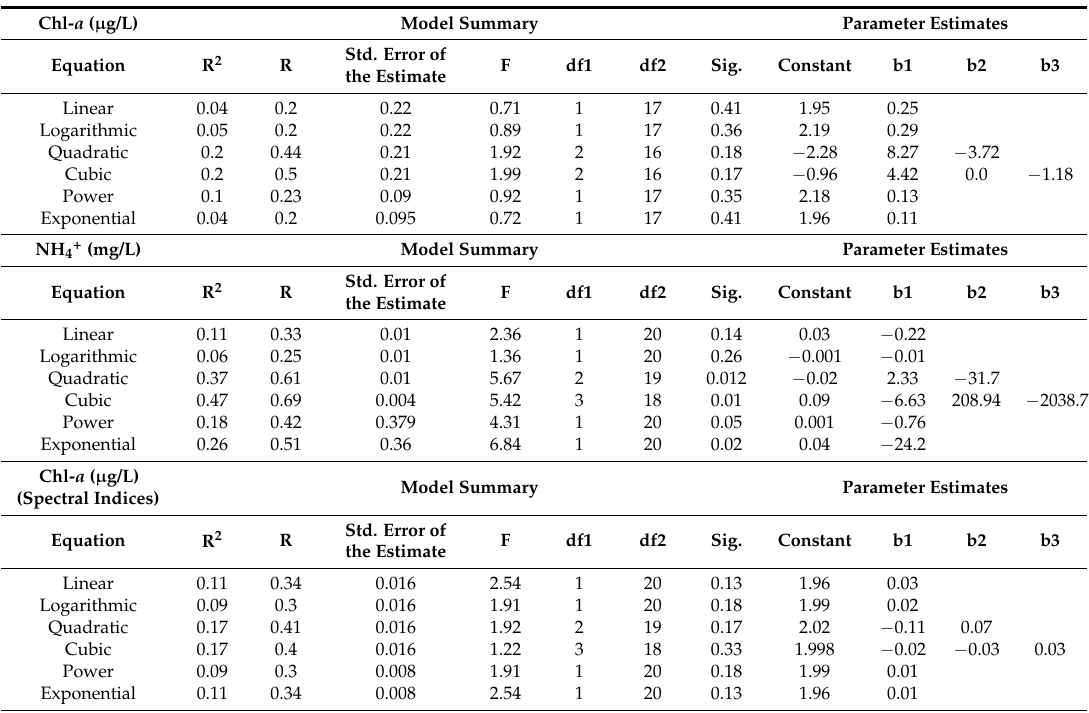
Table 11. Regression analysis statistics and summary of water quality parameters’ predictive models, used in the validation process. Explanation of results: R 2 : the proportion of variance in the dependent variable which can be predicted from the independent variables, R: Correlation coefficient, Std. Error of the Estimate: measure of the accuracy of predictions, F value: the ratio of the mean regression sum of squares divided by the mean error sum of squares, df1-df2: degrees of freedom, Sig.: Significance, Constant: Y intercept, b1-b2-b3: least squares